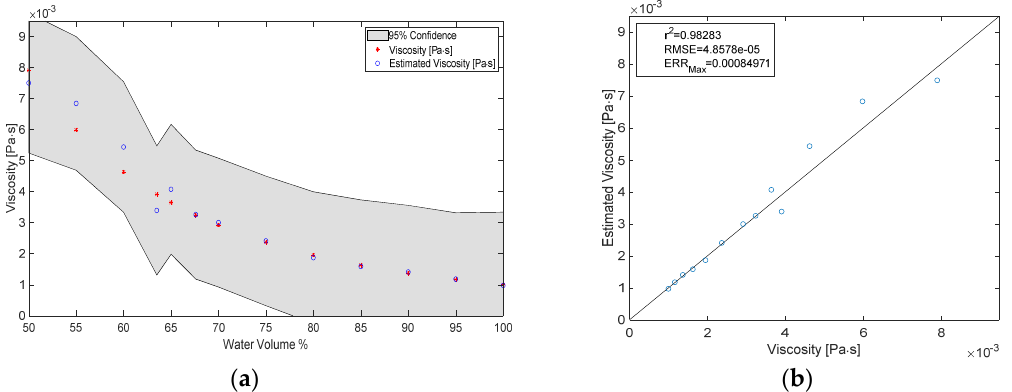
Figure 8. ( a ) Results of the viscosity estimation plotted versus volume fraction after inclusion of the 0.33 and 0.365 volume fraction points in the training process; ( b ) Fitness metrics of the estimation.